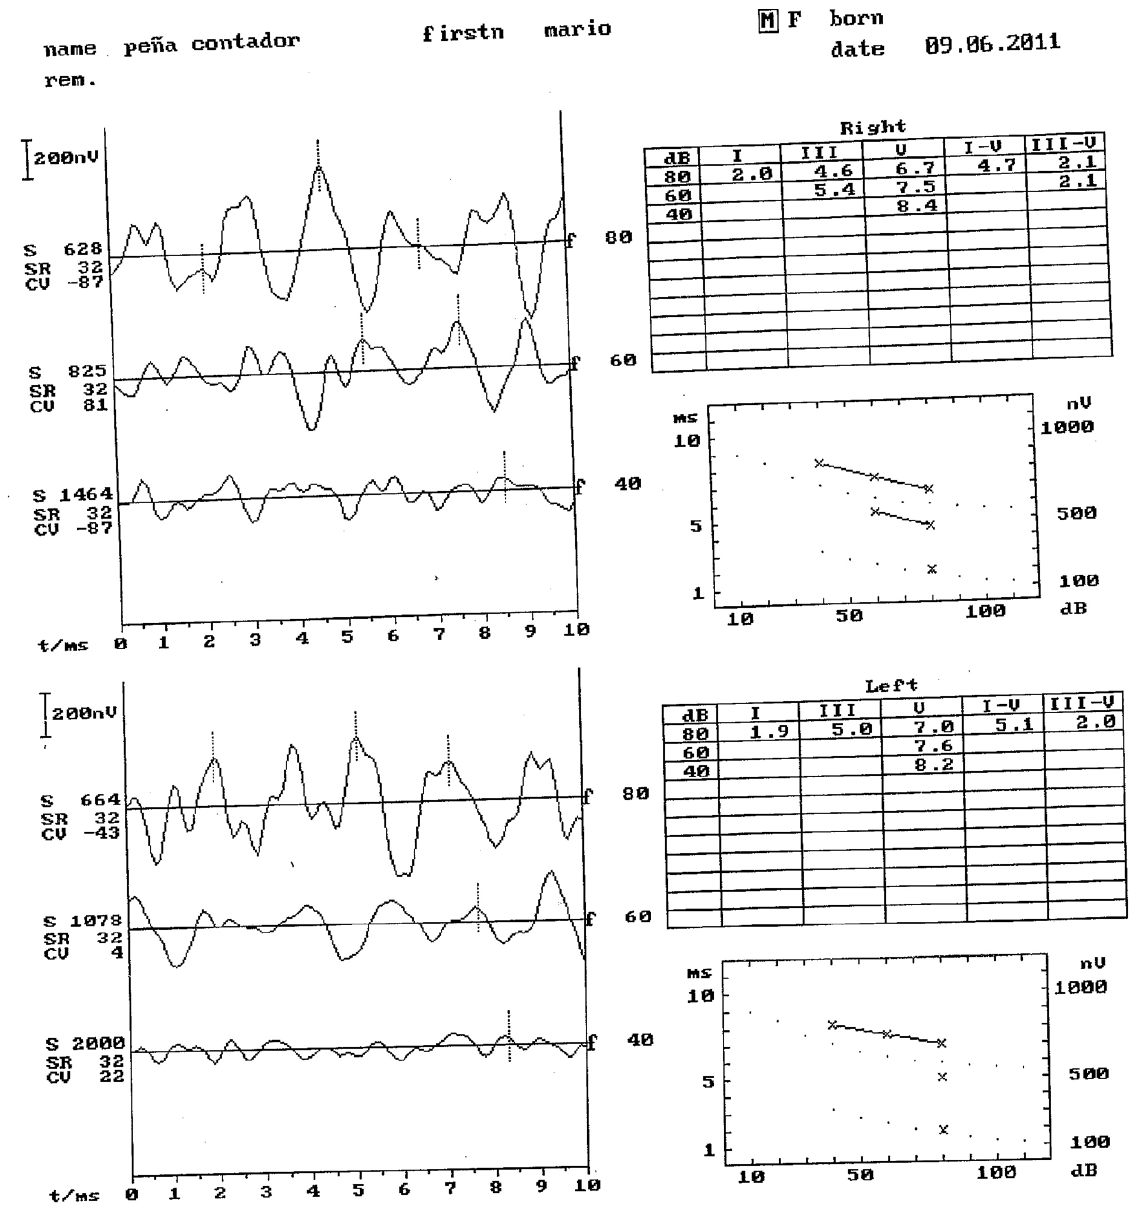
Figure 5. Auditory Figure 5. Auditory potentials.